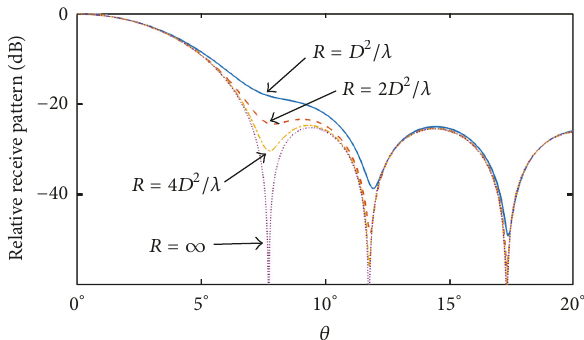
Figure 5: Time delay in the near field of an antenna.